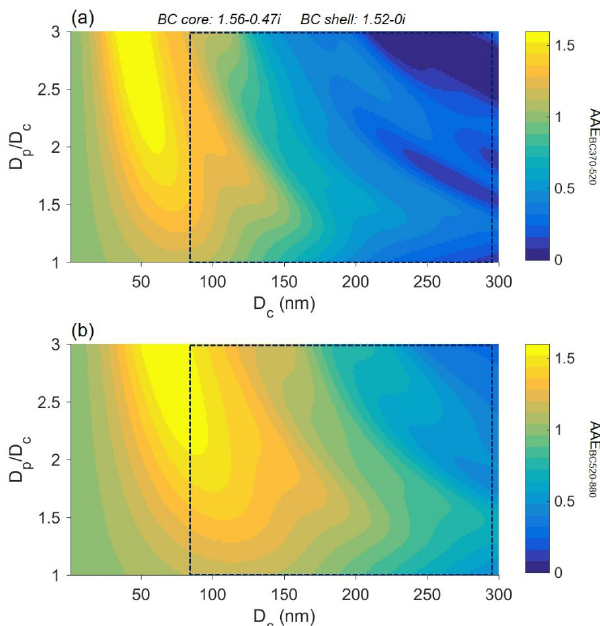
Figure 1. Variation of absorption Ångström exponents between (a) 370 and 520nm (AAE BC370–520 ) and between (b) 520 and 880nm (AAE BC520–880 ) along with core diameter ( D c ) and the coating thickness ( D p /D c ) of clear (pure scattering) shell simu- lated with the core-shell Mie model. The refractive index (RI) of the BC core is set to be 1 . 56 − 0 . 47 i according to Dalzell and Sarofim (1969) and 1 . 52 − 0 i for a clear shell (Pitchford et al.,